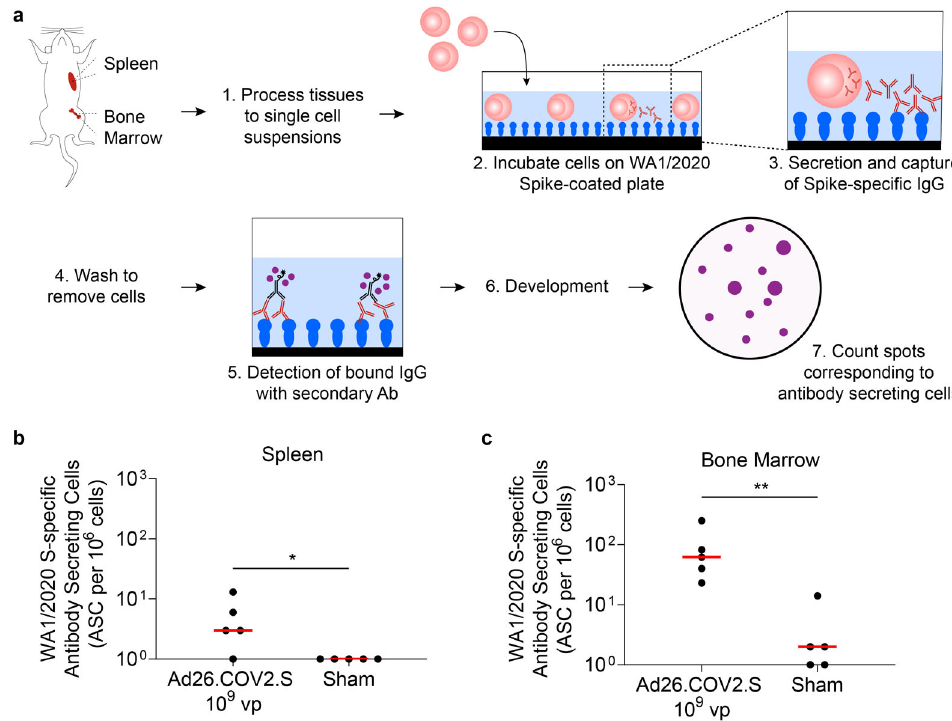
Fig. 4 Antibody-secreting cells in Ad26.COV2.S vaccinated mice are present in spleen and bone marrow. The presence of antibody- secreting cells was assessed by ELISPOT at 15 months postimmunization in mice immunized with Ad26.COV2.S 1 × 10 9 vp ( N = 5) or Sham ( N = 5). a Schematic illustrating the antibody-secreting cell ELISPOT experiment design in which cells were obtained from ( b ) spleen or ( c ) bone marrow and plated on wells coated with WA1/2020 full-length spike. Spot forming cells (SFCs) were normalized per 10 6 cells plated. Horizontal bars re fl ect median SFC per 10 6 cells. P values re fl ect two-sided Mann-Whitney tests (* P < 0.05; ** P <